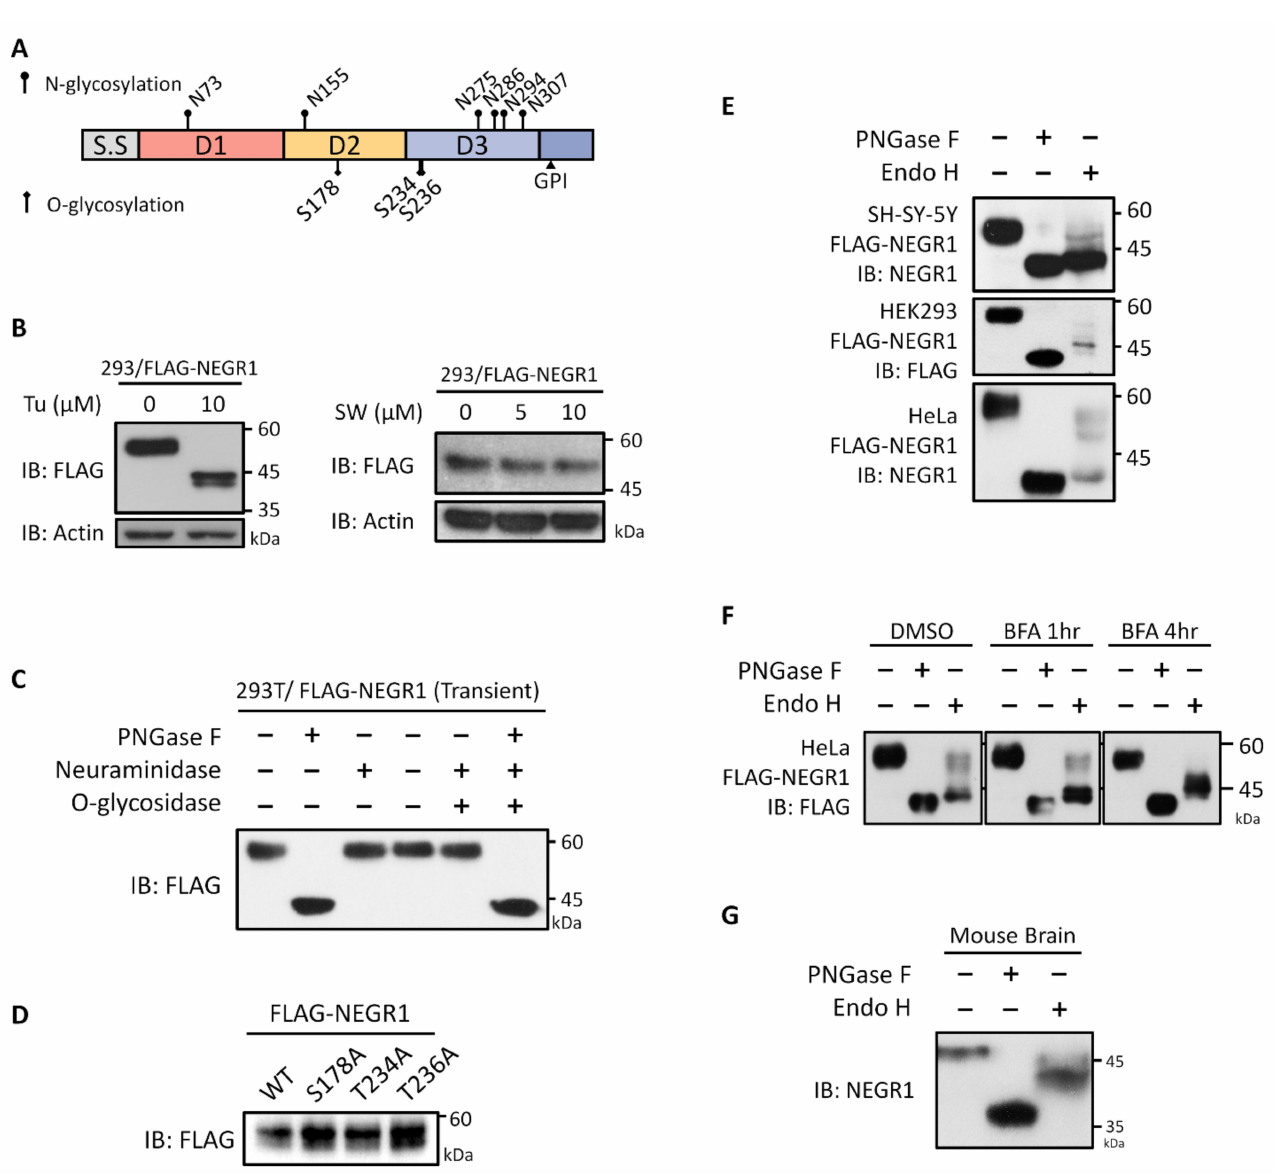
Figure 1. Characterization of glycosyl moieties of neuronal growth regulator 1 (NEGR1). ( A ) Schematic diagram of putative N - and O -glycosylation sites in NEGR1. S.S., Signal sequence; D1-3, Ig-like domains; GPI, glycosylphosphatidylinositol-anchoring site. ( B ) After transfection of FLAG-NEGR1, 293 cells were further incubated with different concentration of tunicamycin (Tu) or swainsonine (SW) for 2 h. ( C ) After transfection of FLAG-NEGR1 plasmids, 293T cell lysates were incubated with peptide N -glycosidase F (PNGase F), N -neuraminidase, or O -glycosidase for 90 min. ( D ) Western blotting of NEGR1 proteins that mutated at putative O -glycosylation sites. ( E ) At 24 h post-transfection of FLAG-NEGR1, cell lysates were obtained and incubated with PNGase F or Endo H for 90 min at 37 ◦ C. ( F ) After transfection with FLAG-NEGR1 for 24 h, HeLa cells were further incubated with 5 µ M brefeldin A (BFA) prior to enzyme digestion. ( G ) Enzymatic deglycosylation using mouse brain tissues obtained from 11-week-old male C57BL/6